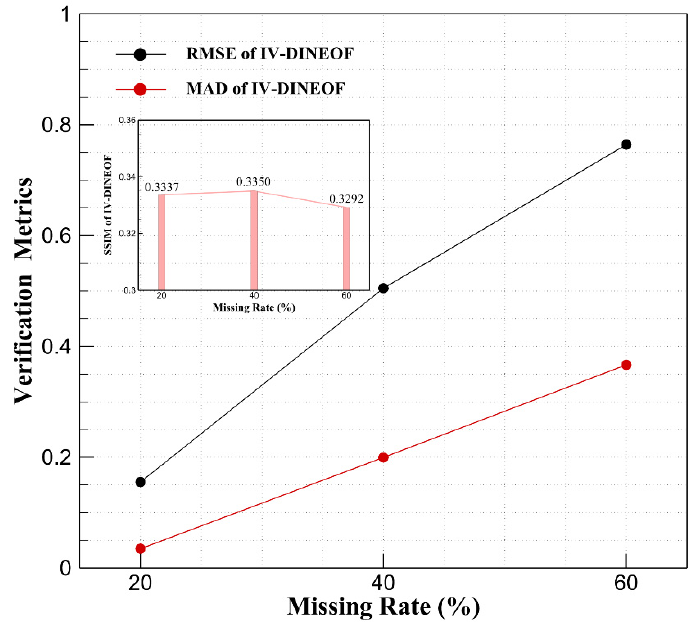
Figure 5. RMSE and MAD of IV − DINEOF with different missing rates.